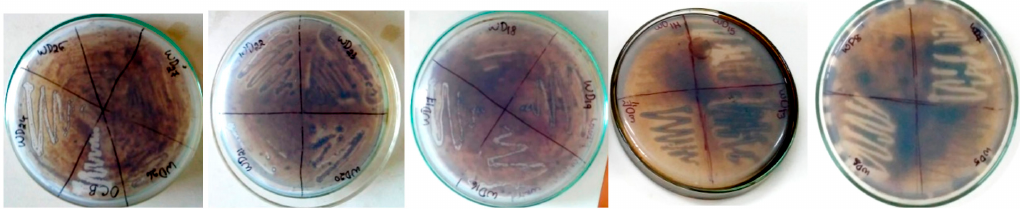
Fig. 2. Bacterial isolates exhibiting growth and zone of clearance on BH plates supplemented with PCO, at 2 days of incubation